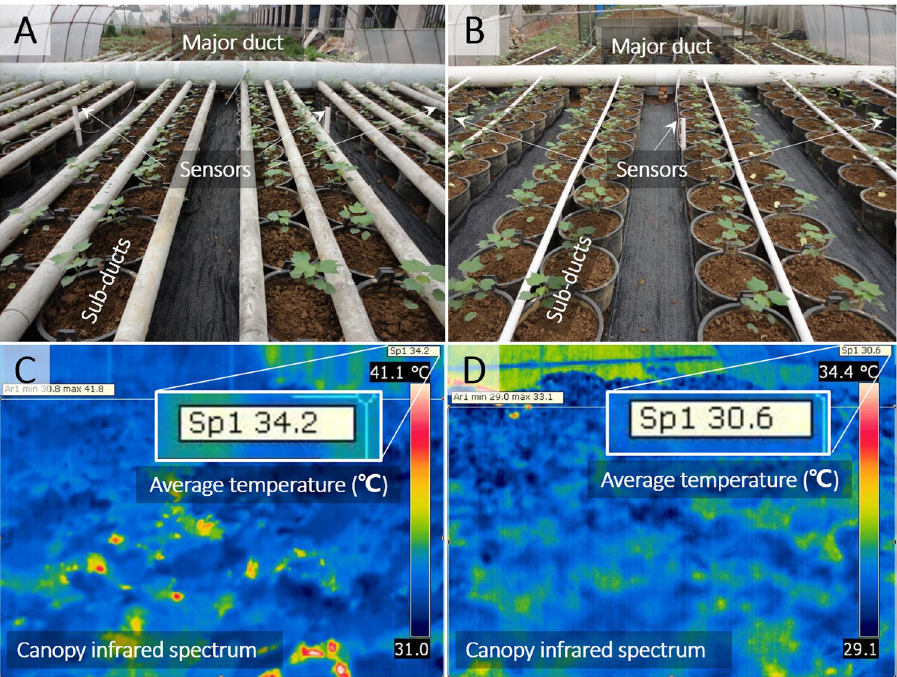
Figure 2. Ducts arrangement in cotton field, and the infrared spectrum of cotton canopy. In the Elevated temperature region ( A ), warm air had been blown into a major duct with 36 sub-ducts connected. The ducts is made of PVC, and covered with insulation sponge. In the control region ( B ), ambient (atmospheric) air had been blown into a major duct with 12 sub-ducts connected. Six temperature sensors were equidistributed in each region, which were located at the height of 6 th fruiting branch (about 80 cm off the ground). The canopy infrared spectrum of two temperature regions were presented ( C , D ), with a 3.6 °C difference in average between two regions.